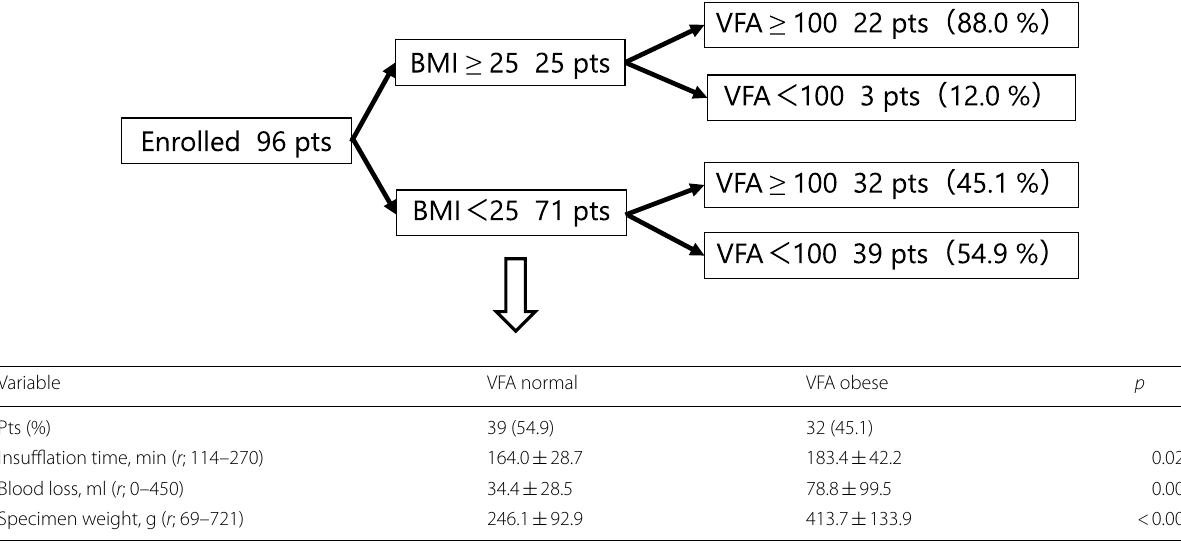
Data are presented as mean